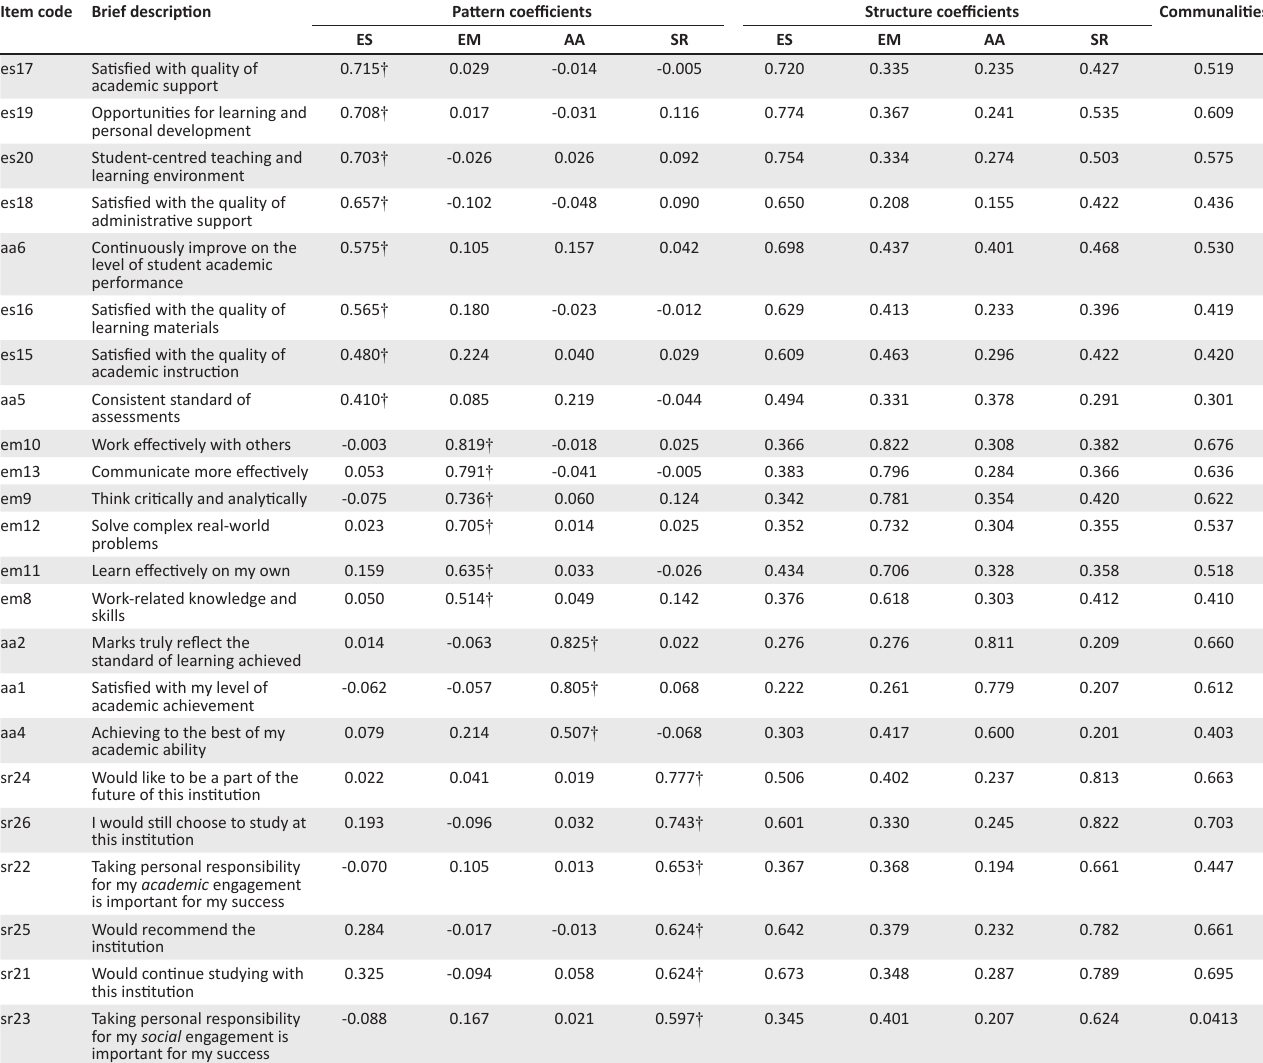
TABLE 6: Pattern and structure matrix for student educational outcomes effectiveness questionnaire after dropping low loading